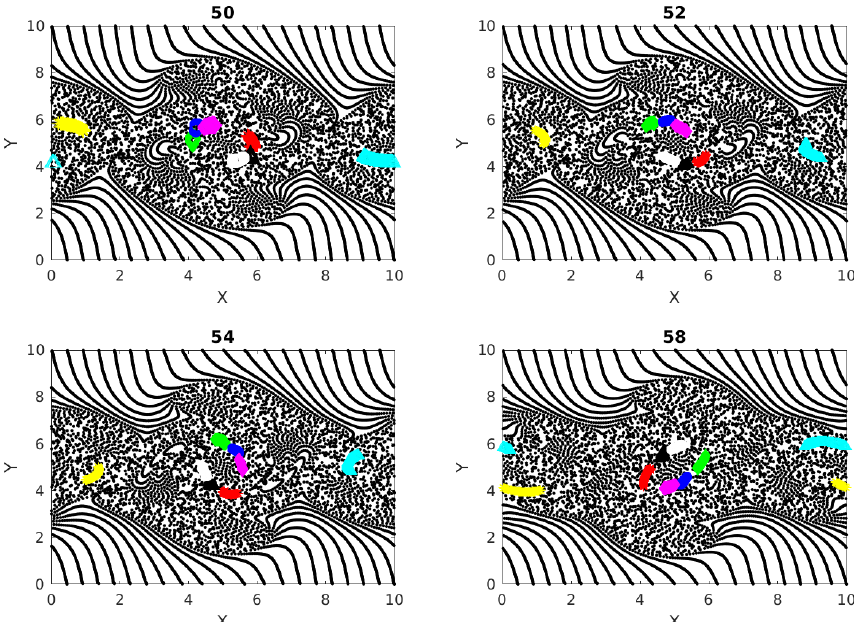
Figure 4. Cumulative clusters found at time 50 with threshold distance for interaction (cid:15) = 20% of initial separation of particles on uniform rectangular grid and tracked at later time steps (52, 54 and 58). Changing colors denote the merging of two clusters when particles from two clusters interact.